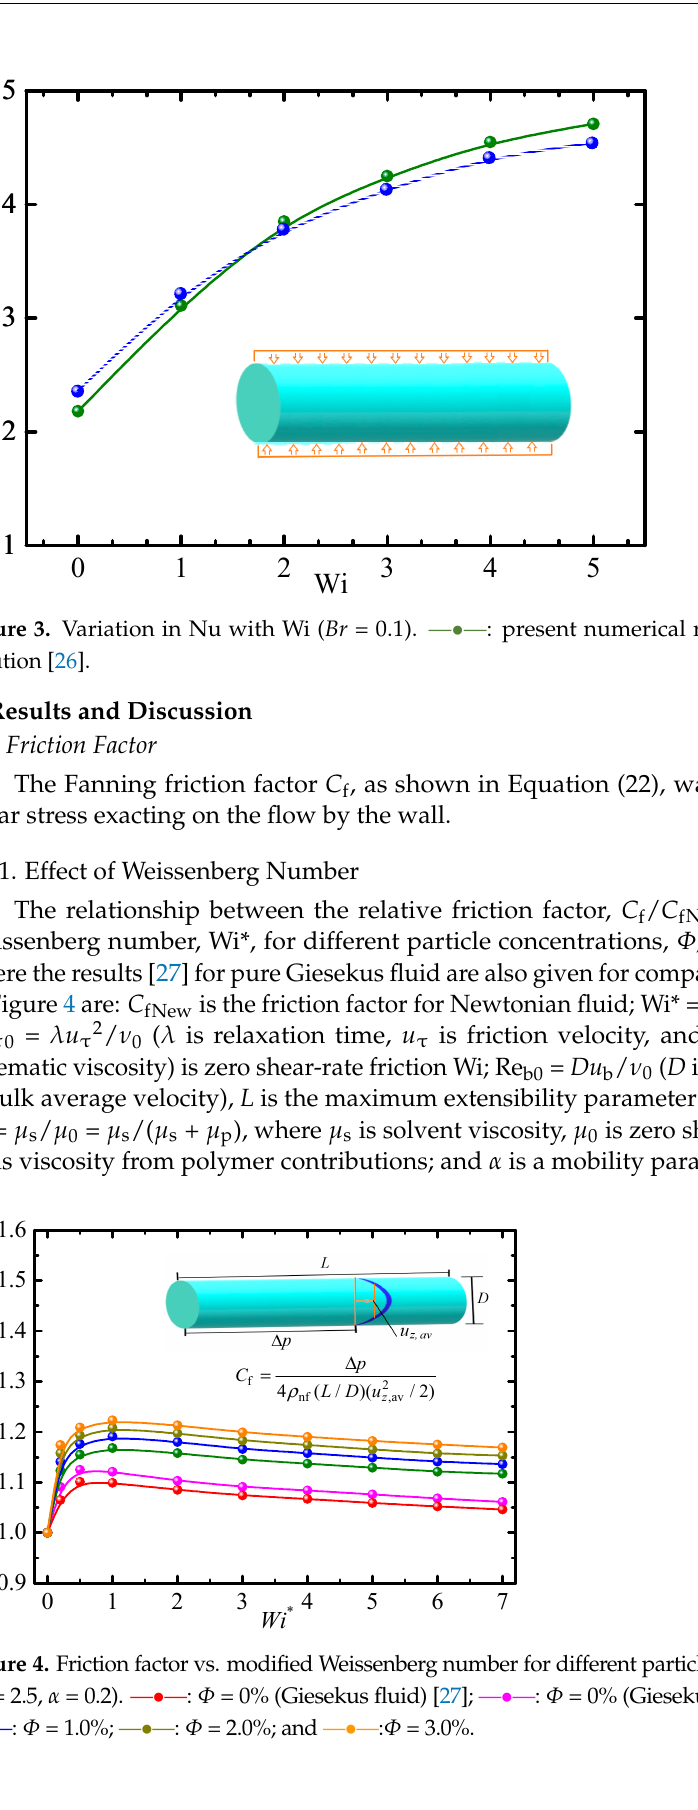
Figure 4. Friction factor vs. modified Weissenberg number for different particle concentrations ( β 0 = 0.2, Re = 2.5, α = 0.2). ⸺ ● ⸺ : Φ = 0% (Giesekus fluid) [27]; ⸺ ● ⸺ : Φ =0% (Giesekus fluid); ⸺ ● ⸺ : Φ =0.5%; ⸺ ● ⸺ : Φ = 1.0%; ⸺ ● ⸺ : Φ = 2.0%; and ⸺ ● ⸺ : Φ = 3.0%. From Figure 4, we can see that C f / C fNew is always larger than 1, i.e., the C f of Giesekus-fluid-based nanofluids is larger than that of Newtonian fluid. C f / C fNew = 1 when Wi* = 0 because Wi* = 2Wi τ 0 /( Re b0 L ) is the ratio of elastic force to inertial force; Wi* = 0 for Newtonian fluid. As Wi * increases, C f / C fNew increases rapidly when 0 < Wi* < 0.5 and slowly when 0.5 < Wi* < 1, and then it decreases slowly when 1 < Wi*< 7. Wi is also the ratio of the first normal stress difference (FNSD) to shear stress. When 0 < Wi* < 1, the increase in Wi* means an increase in FNSD, so as to produce additional extension re- sistance and result in an increase in C f . When 1 < Wi* < 7, the effect of the increase in